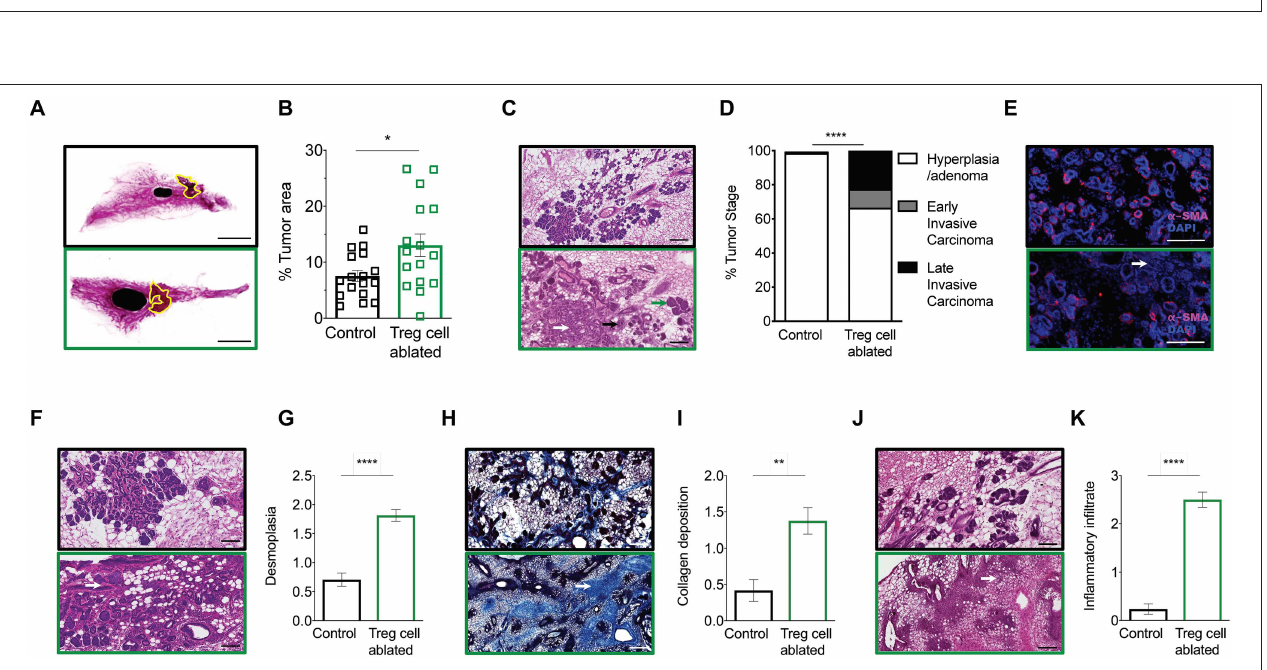
Frontiers in Immunology |